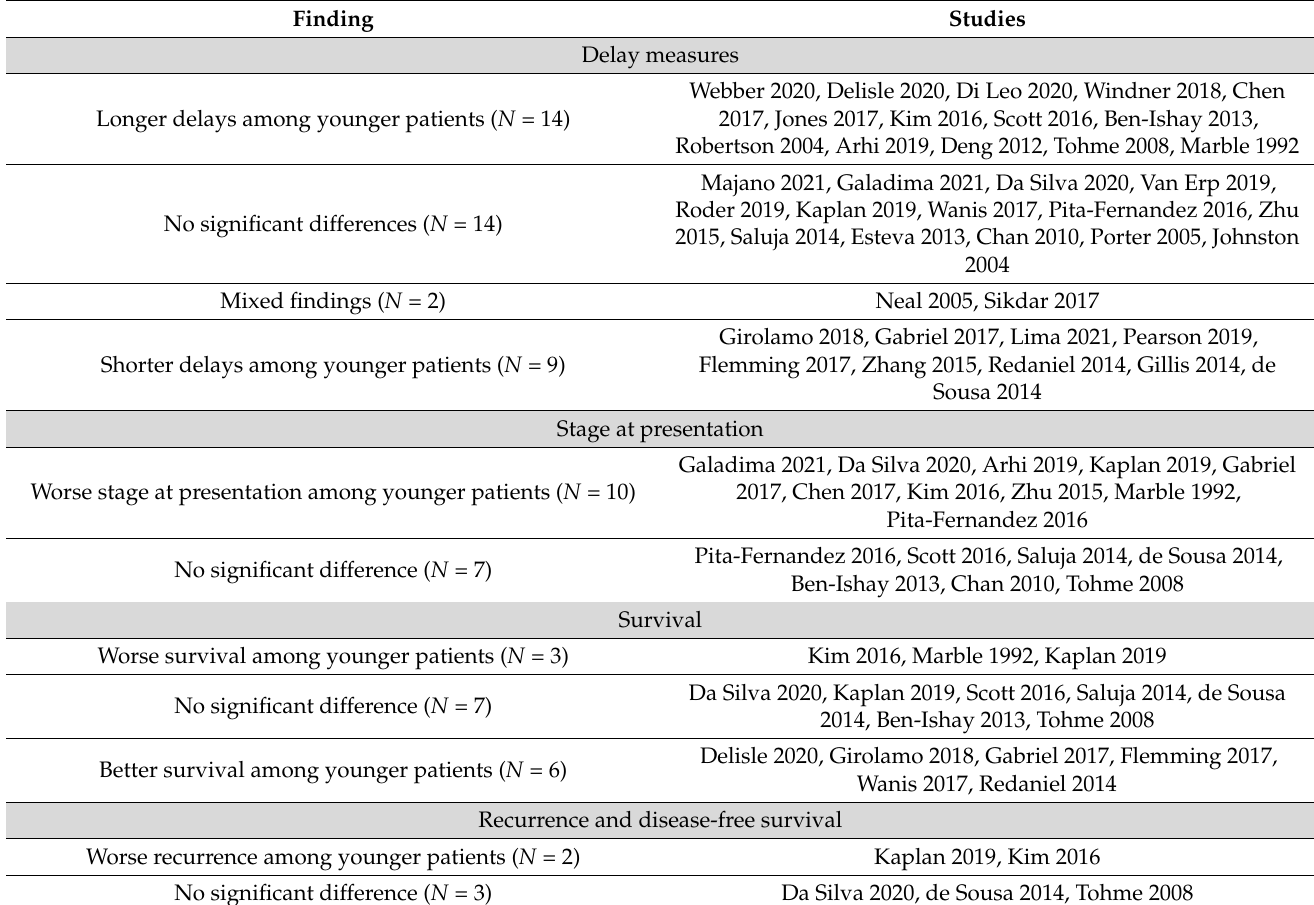
Table 2. Comparison of outcomes between older and younger colorectal cancer patients. Shown are delay measures (all intervals), stage at presentation, overall survival, and disease-free sur-